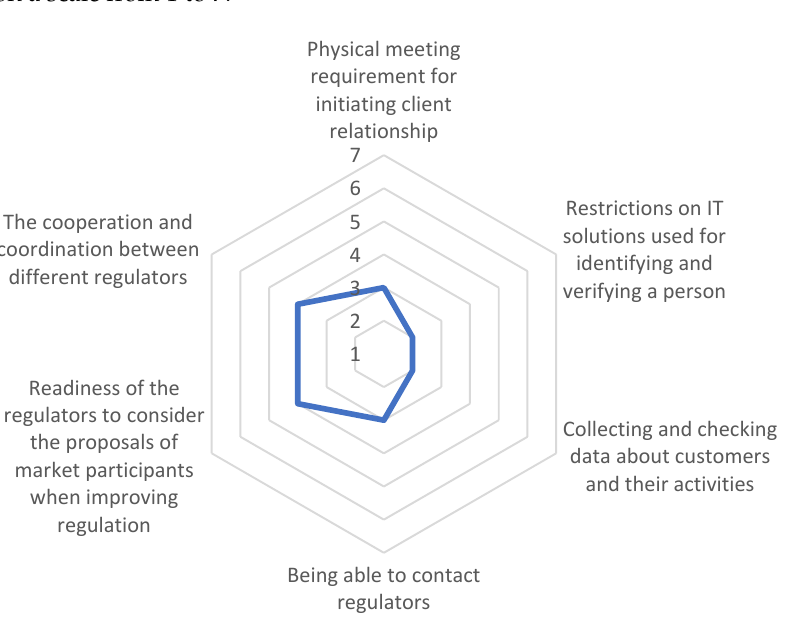
Table 2. Answers to the question of what measures will help the further development of the respondent’s company and/or the Latvian FinTech sector.